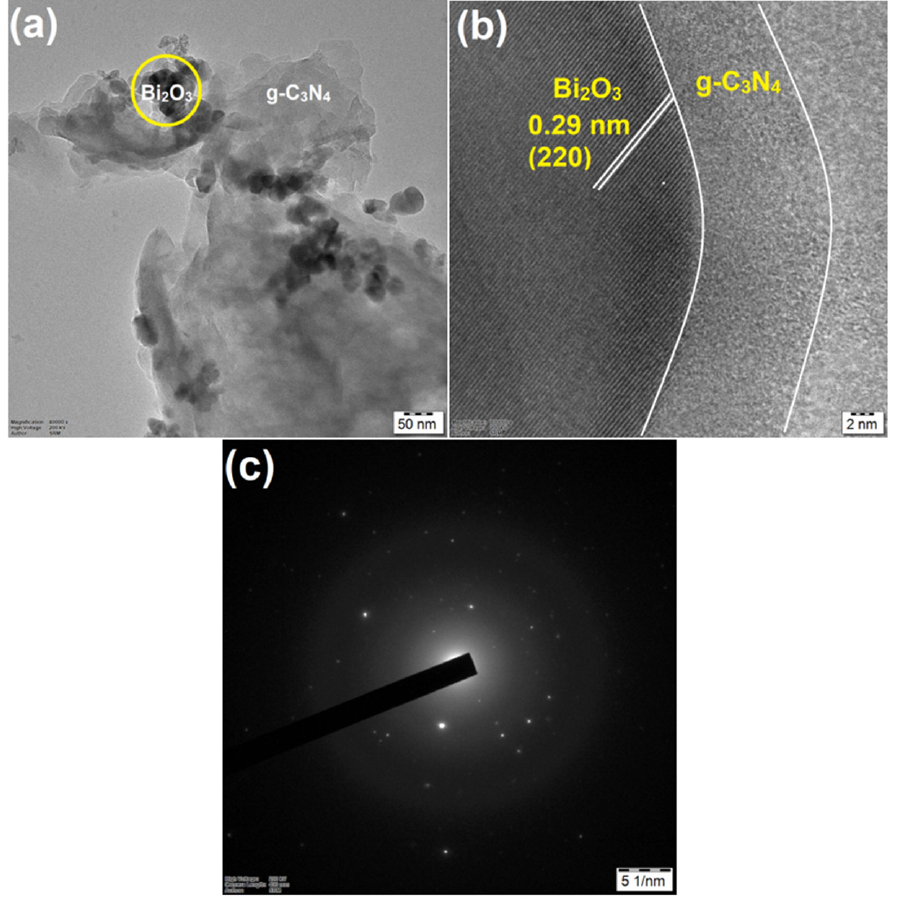
Figure 3. TEM ( a ), HRTEM ( b ) and SAED ( c ) images of 1:1 Bi 2 O 3 /g-C 3 N 4 nanocomposite.